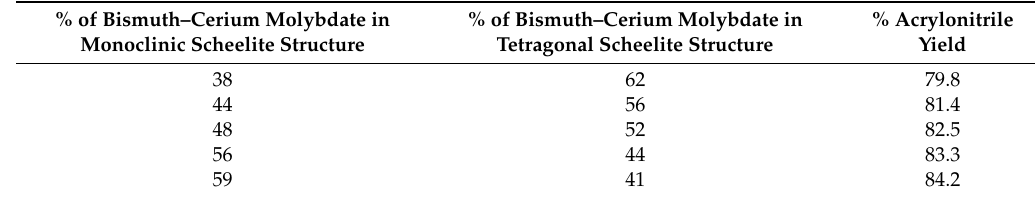
Table 2. Propylene ammoxidation over bismuth–cerium molybdate containing complex mixed-metal- oxide catalysts